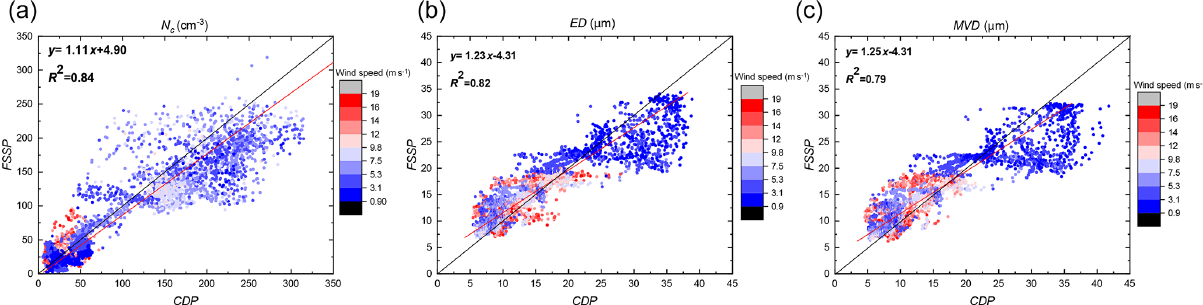
Figure 12. Intercomparison of (a) N c , (b) ED and (c) MVD as it was derived from the CDP and the FSSP is presented for all wind directions. Color code represents the wind